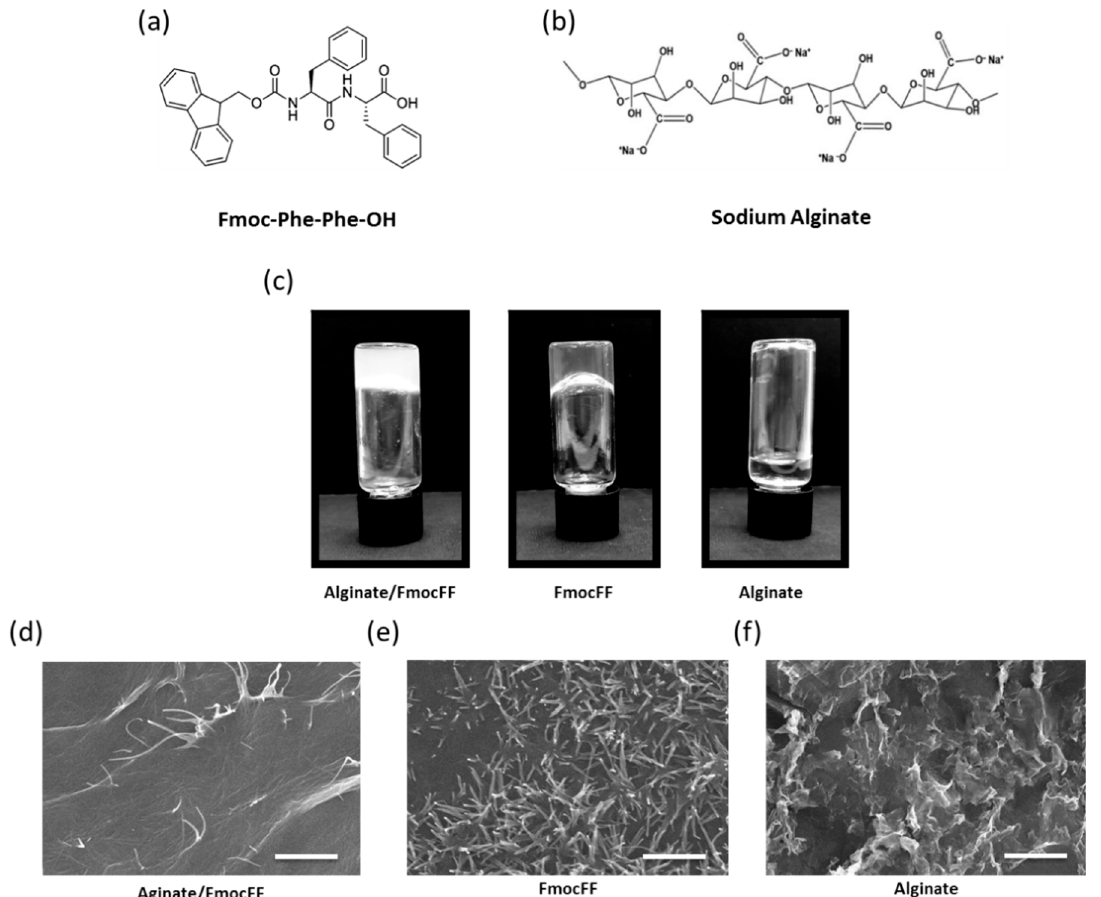
Figure 1. Fabrication and characterization of the Alginate/fluorenylmethoxycarbonyl-diphenylalanine (FmocFF) composite hydrogel. ( a ) Molecular structure of the FmocFF peptide. ( b ) Molecular structure of typical sodium alginate repeated units. ( c ) Inverted vials of the Alginate/FmocFF composite hydrogel and its pure components. ( d – f ) SEM micrographs of ( d ) Alginate/FmocFF composite hydrogel, ( e ) Pure FmocFF hydrogel, and ( f ) Sodium alginate solution. Scale bar = 5 µm.